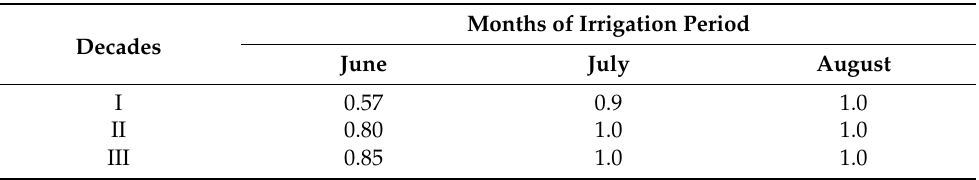
Table 4. Correction coefficients (kr) according to Freeman and Garzoli for decades and months of the irrigation period, to computing crop evapotranspiration for potato cultivar Courage in central Poland, at the limited wetting area (drip irrigation) ([29] modified by authors). Months of Irrigation Period Decades